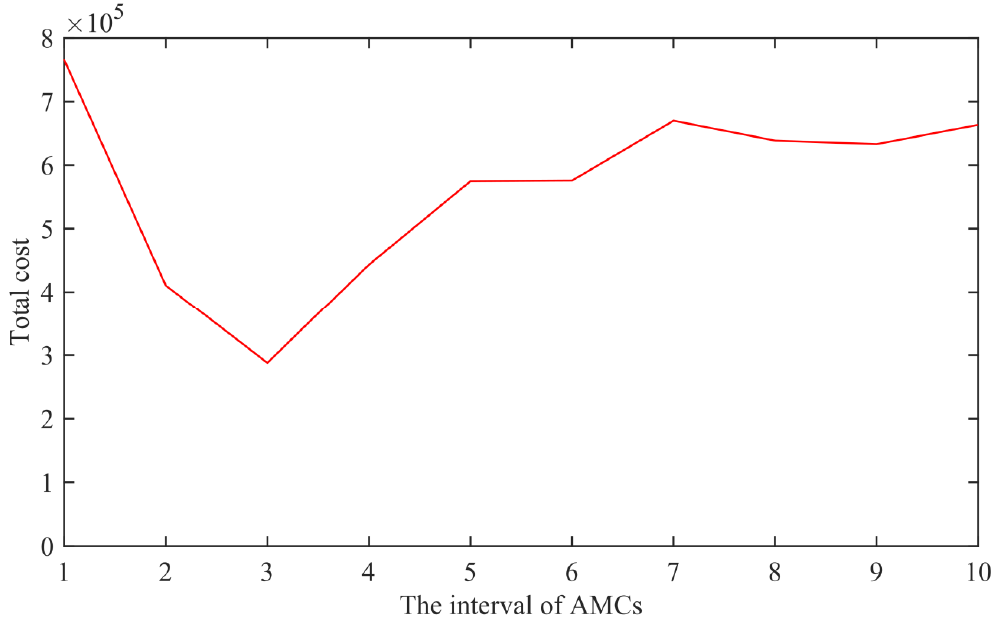
Figure 4. The expected total cost E ( C ) as a function of A for C A 1 = 5000, C A 2 = 0.04 and C P =